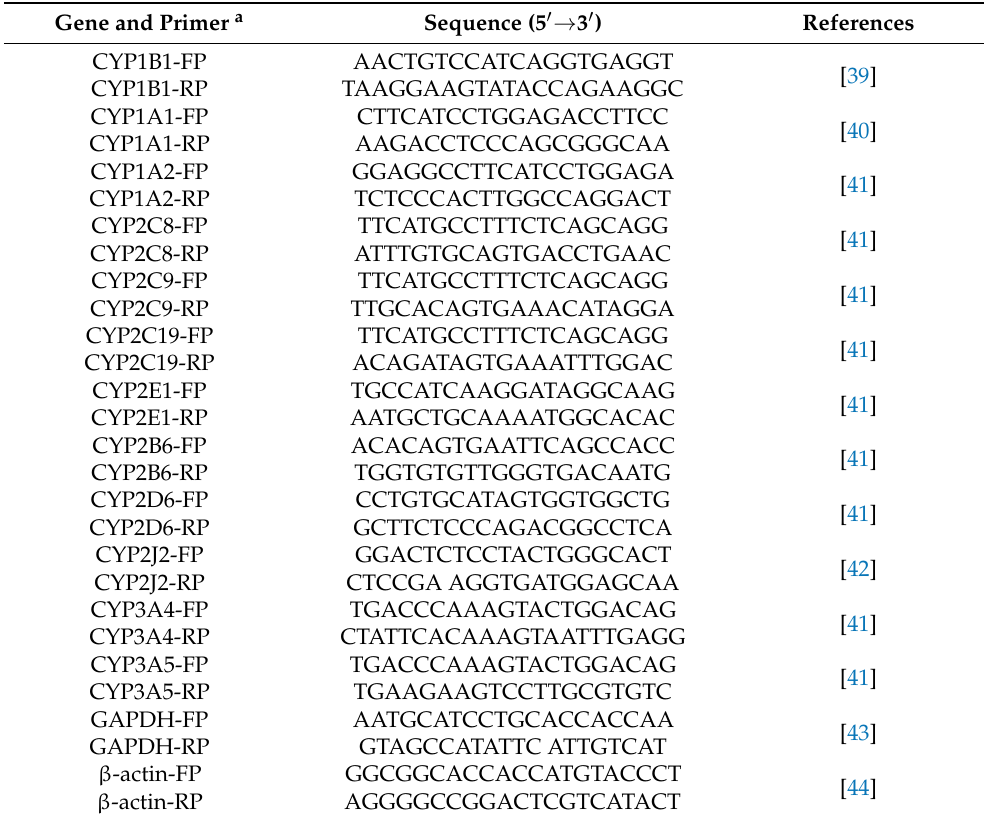
Table 1. Primers for RT-PCR. Gene and Primer